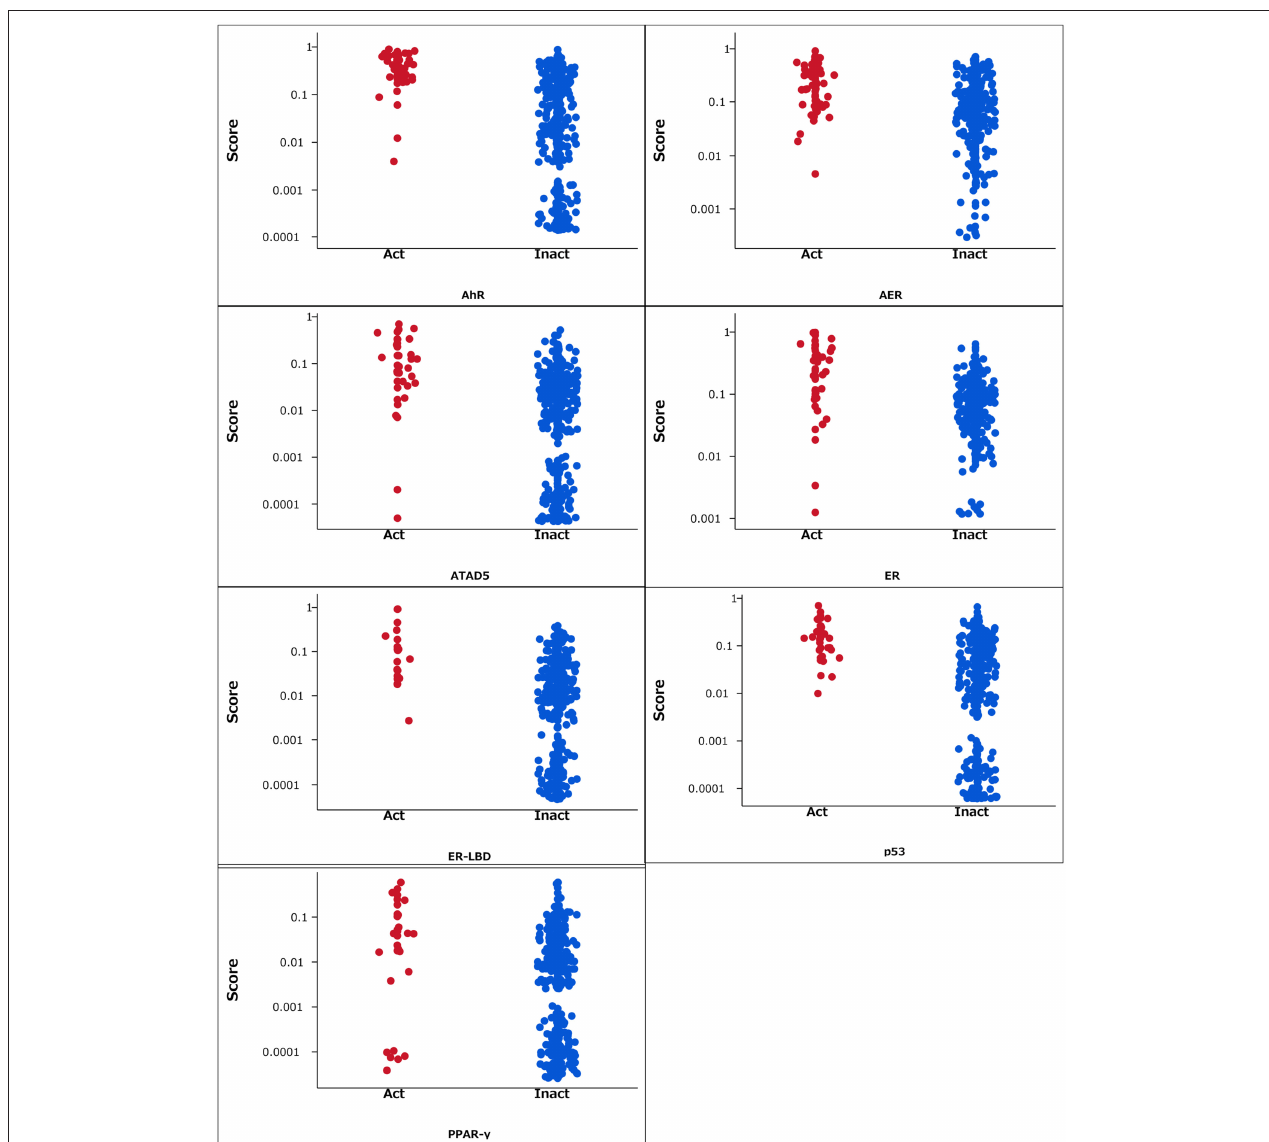
FIGURE 3 | Estimated scores of compounds in the evaluation set. Act and Inact denotes the active and inactive results in each